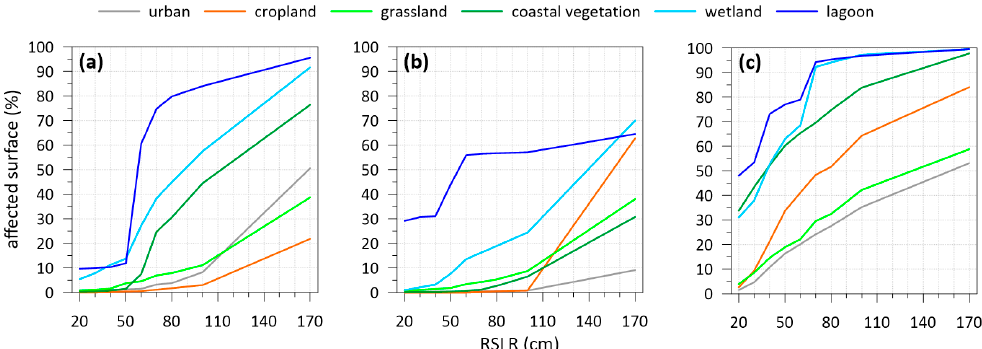
Figure 8. Simulated proportion (%) of main habitat types inundated in the plain of ( a ) GR, ( b ) LD, and ( c ) ED.